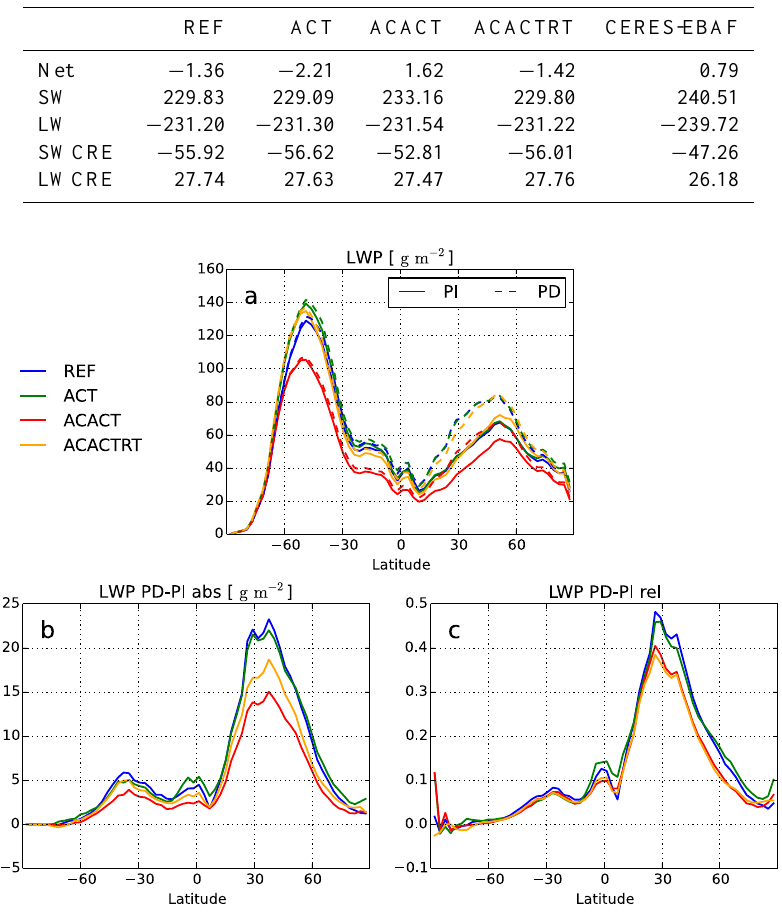
Figure 5. (a) LWP for PI and PD conditions in gm − 2 , and (b) the absolute and (c) relative anthropogenic changes in LWP.